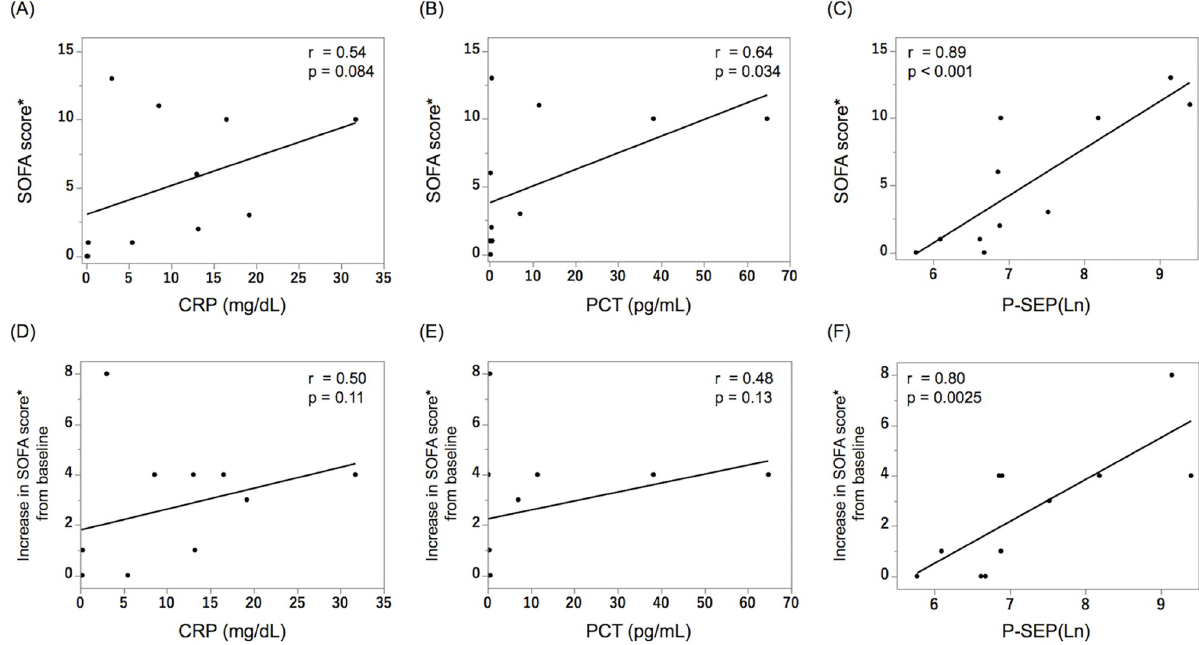
Fig 1. Relationship of the CRP, PCT, and P-SEP concentrations with the SOFA scores. There is a significant association between the PCT levels and the SOFA scores before treatment, but not between CRP and SOFA scores (A, B). The SOFA scores have the strongest positive correlation with the P-SEP concentrations (r = 0.89, p < 0.001, C). The increase from baseline in the SOFA scores has the strongest positive correlation with the P-SEP levels, unlike the others (D–F). Spearman’s rank correlation coefficient was used to examine the relationship between the values and SOFA scores. CRP: C-reactive protein, PCT: procalcitonin, P-SEP: presepsin, SOFA score: Sequential Organ Failure Assessment score, Ln: natural logarithm. � SOFA scores were defined based on laboratory data on day 1 in 9 patients and on day 2 in 2 patients (#8 and #11).